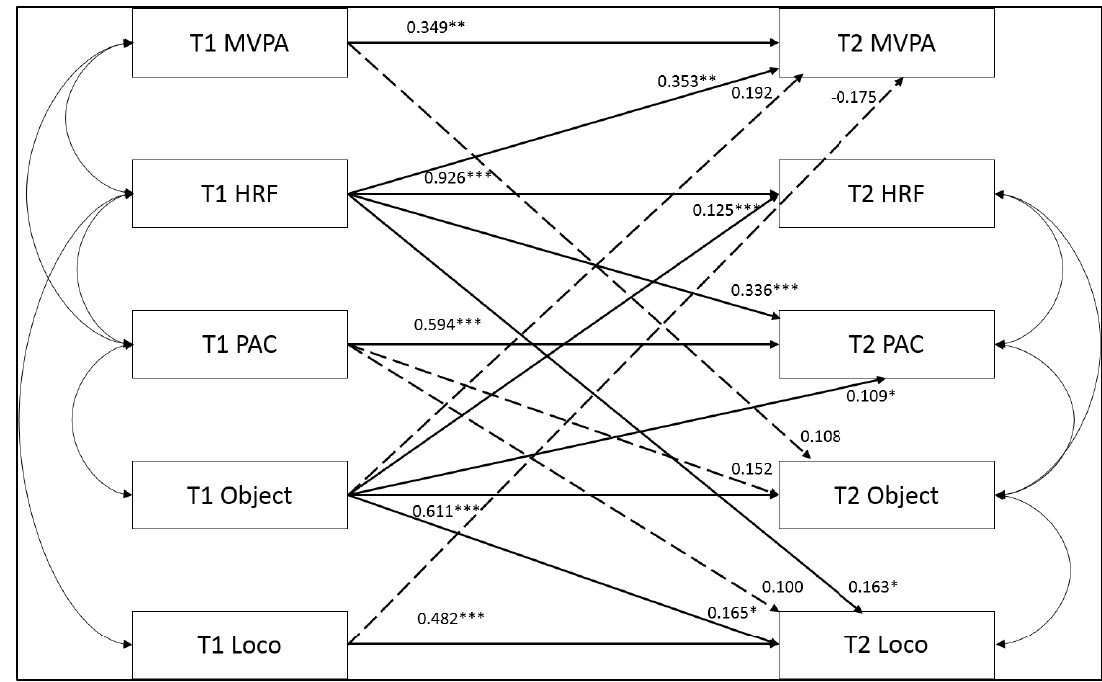
Figure 1. Autoregressive and cross-lagged pathways between variables in 6th class (T1) and 1st year (T2). Note: * Standardised regression coefficients significant at p < 0.05; ** p < 0.01; *** p < 0.001. Dashed line = non-significant pathway.